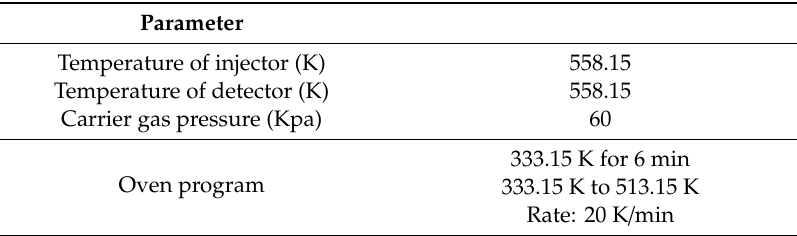
Table 3. Gas chromatography operating